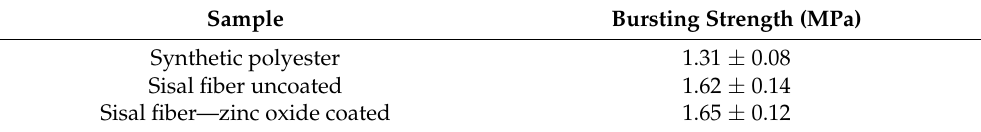
Table 2. Bursting strength test result.